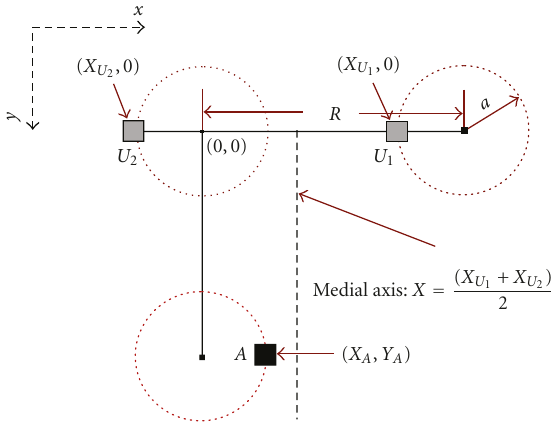
Figure 5: Schematic of the node localization tolerance.